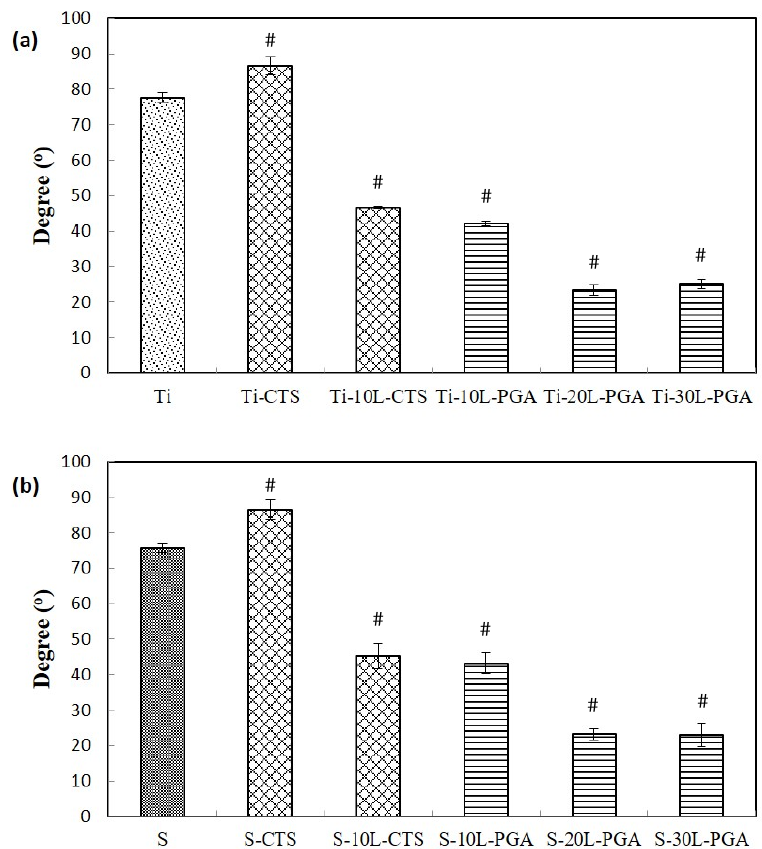
Figure 4. Contact angles with respect to water of ( a ) Ti6Al4V substrate with different layers of C/PGA multilayer coatings, and ( b ) 316LSS substrate with different layers of PEMs coating. #: p < 0.01 compared to bare Ti6Al4V or 316LSS substrate.